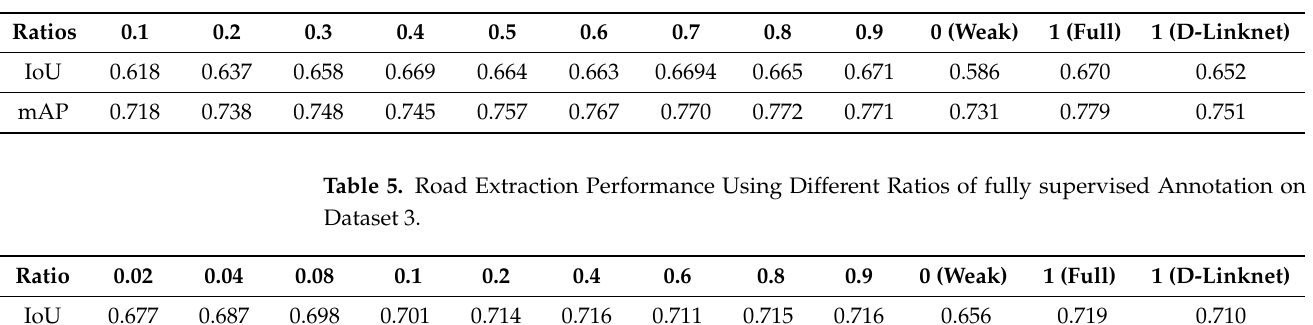
Table 4. Road Extraction Performance Using Different Ratios of fully supervised Annotation on Dataset 2.